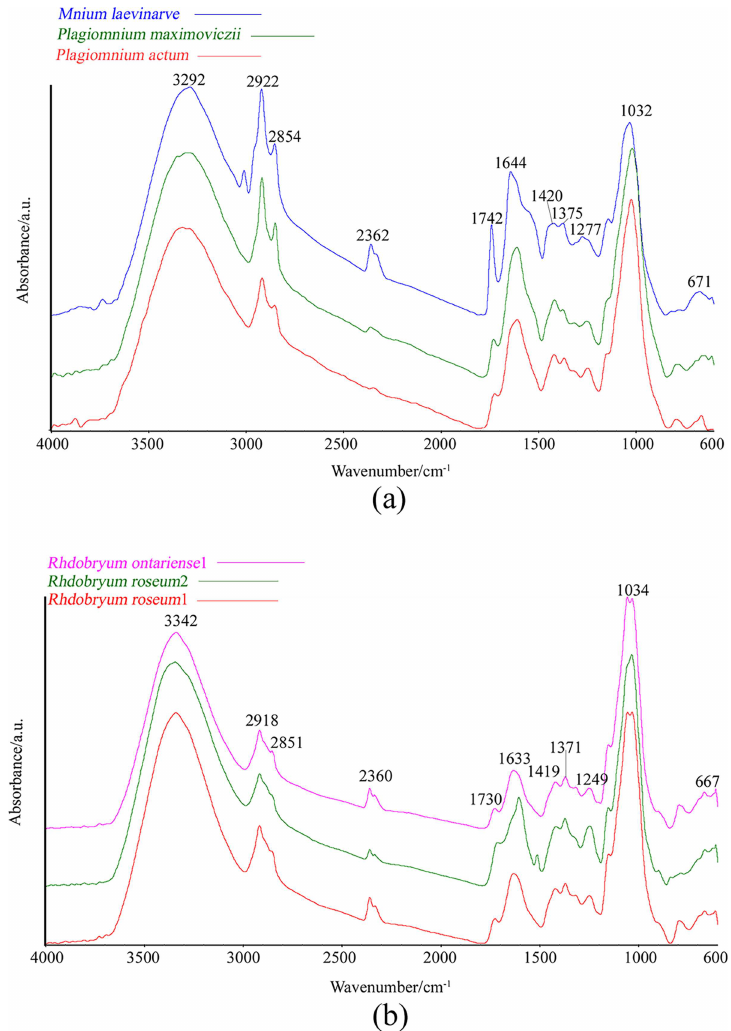
Fig 1. FTIR–ATR Spectra Obtained at 4000–600cm − 1 for Six Samples. The Main Peaks are Labeled at the Top of the